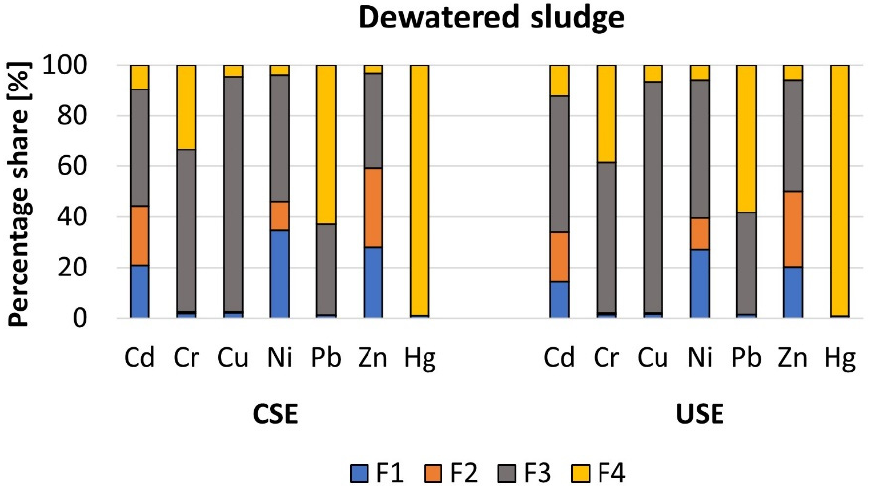
Figure 5. Percentage share of heavy metals in the different chemical fractions of dewatered sludge.